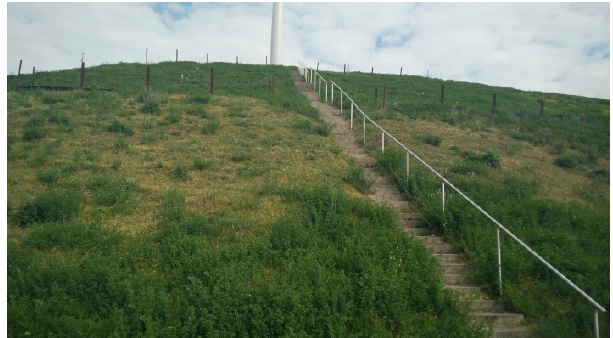
Figure 4. Lysimeter Field 2 (visible in the upper part of the image between vertical